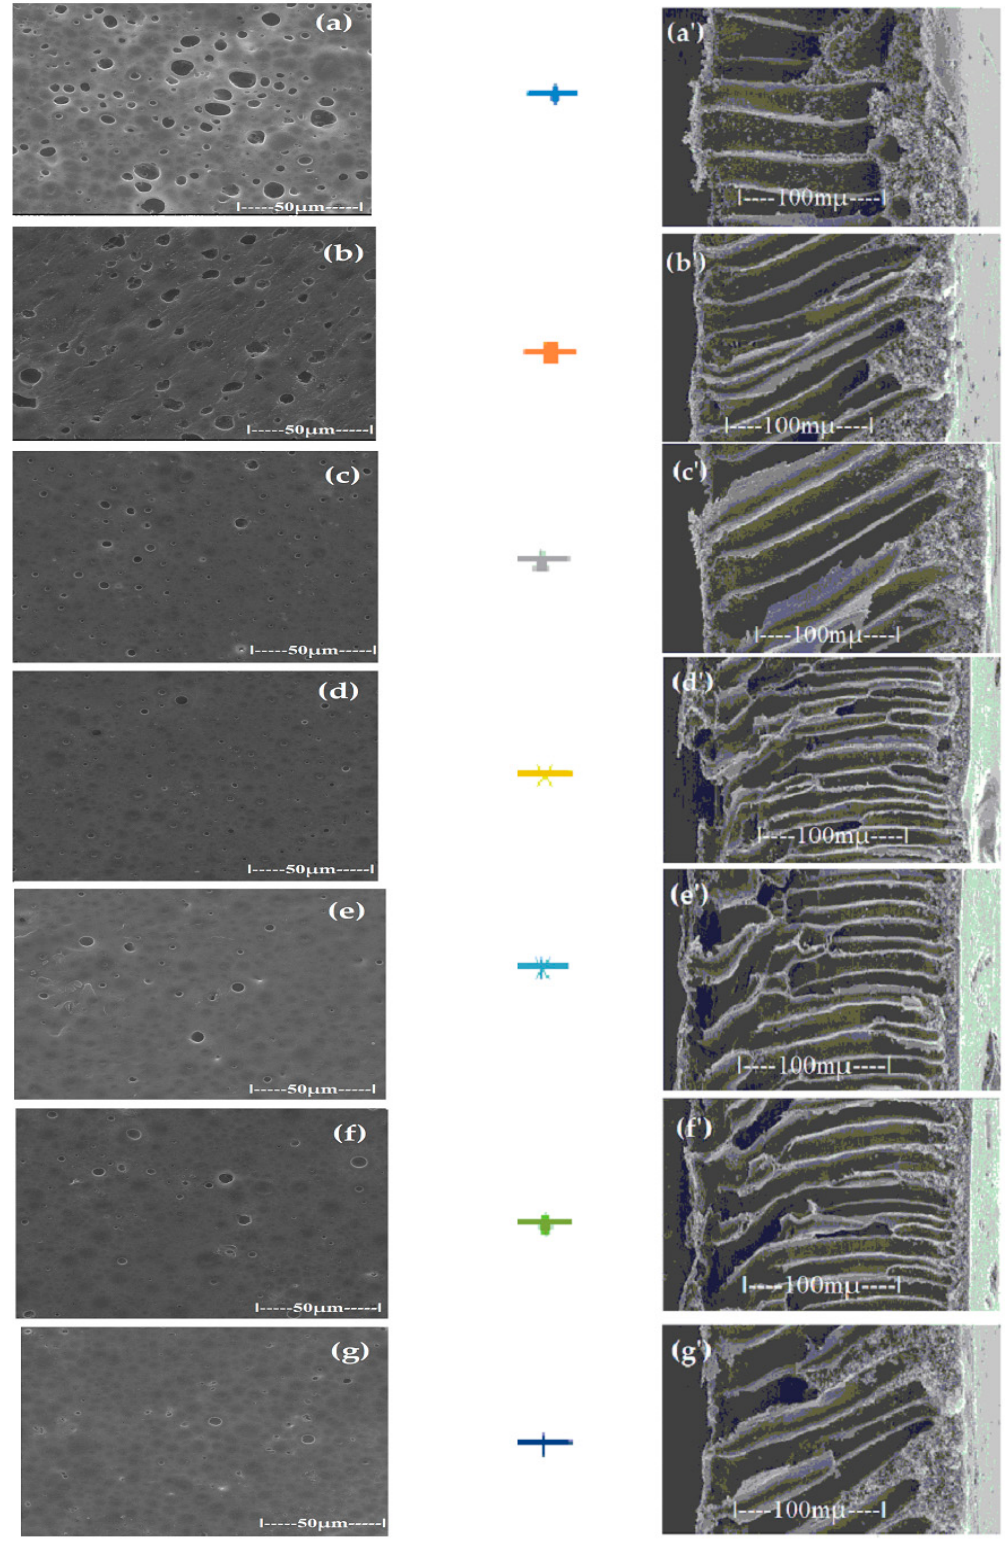
Figure 8. Morphology of polysulfone support membranes obtained by different exposure to the polymeric film before coagulation: ( a – g ) bottom views and ( a’ – g’ ) cross-sections.